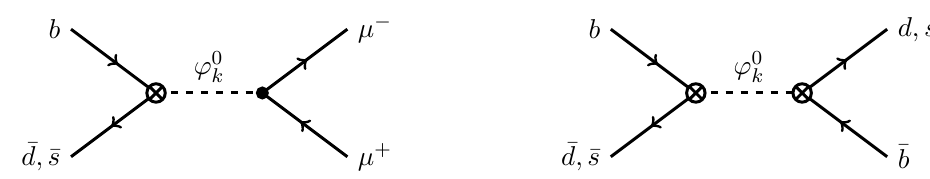
Figure 2. Feynman diagrams contributing to (cid:22) B 0 ! (cid:22) + (cid:22) (cid:0) (left) and B 0 - (cid:22) B 0 mixing (right). The crossed vertex represents the one-loop e(cid:11)ective FCNC neutral interaction in eq.